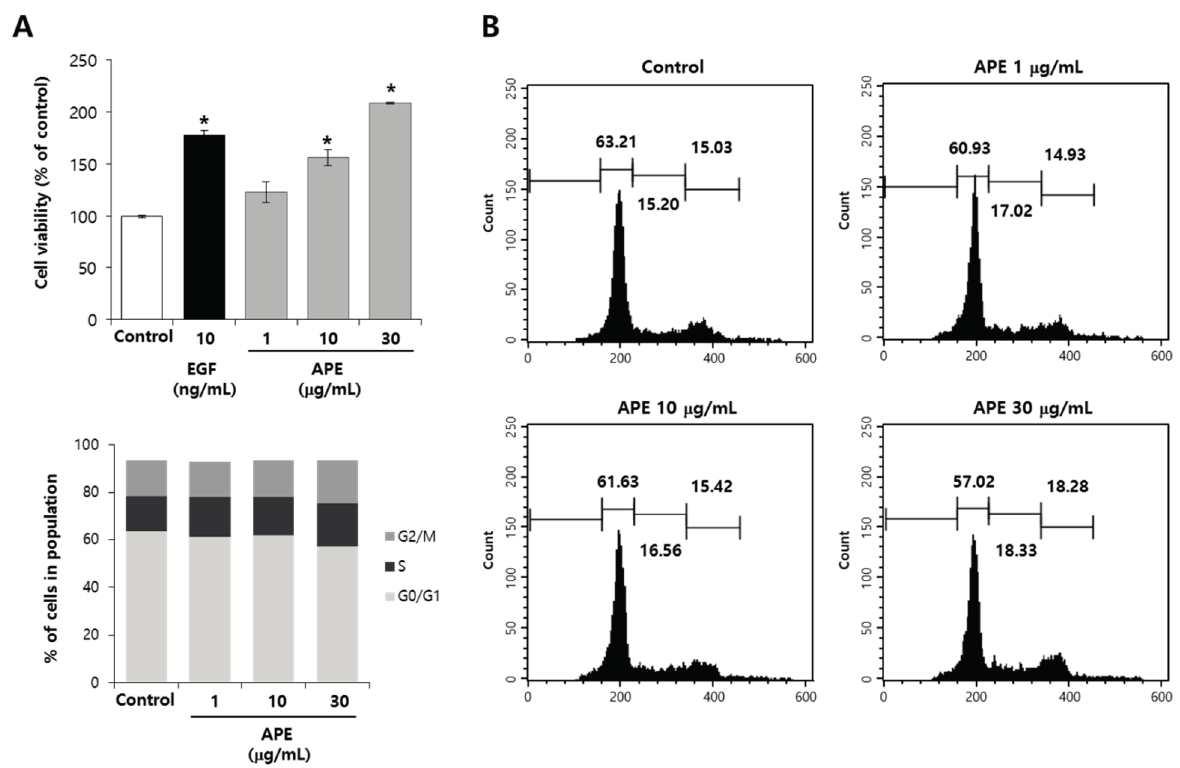
Figure 1. APE induced proliferation of EpSCs. ( A ) The EpSCs were cultured in a serum-free condition, with the APE, for three days; the proliferation was measured by MTT; ( B ) Under the same condition for 24 h, the cell cycle distribution was evaluated by using a flow cytometry analysis with PI staining. Indicated values are suggested as 100% of the control ( n = 3). The data are presented as the mean ± SD, * p <